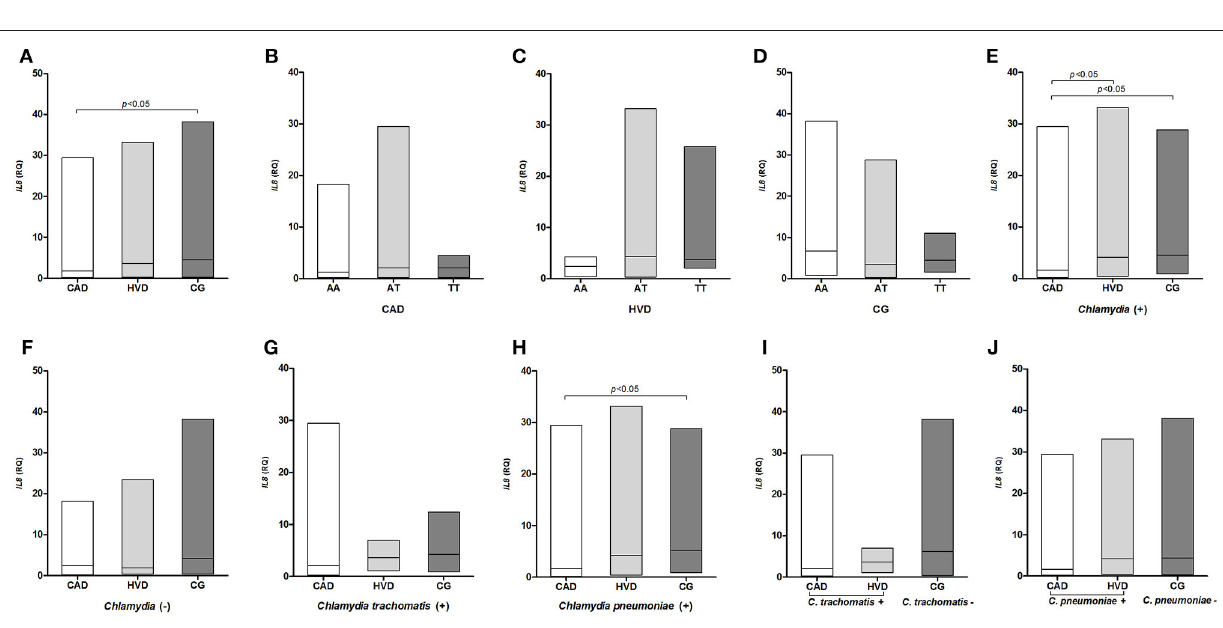
among adults, who have high prevalence of antibodies (26,